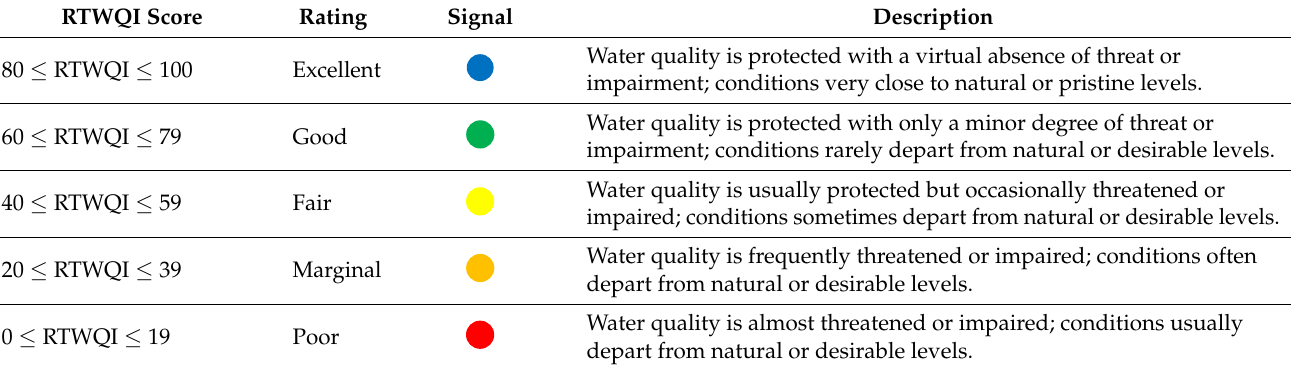
Table 2. Classification of surface water quality according to the RTWQI score and rating [39].